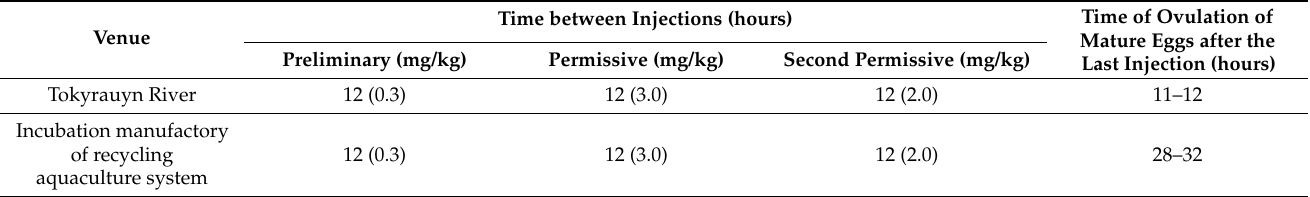
Table 6. Timing of hormonal stimulation and recommended doses of carp pituitary solution used to stimulate marinka